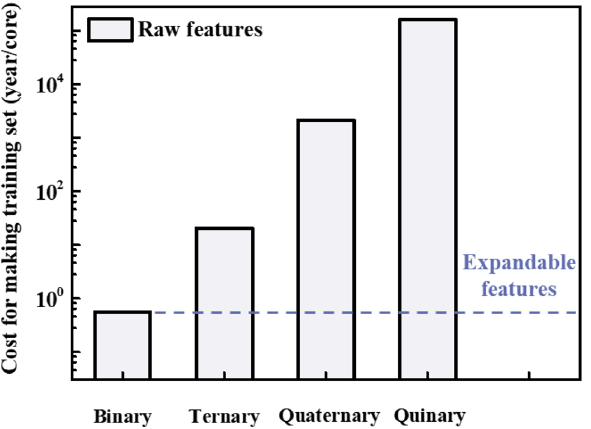
Figure 4. ( a ) S c of binary alloy as a function of c (Gray line). S alloy can have. Beige color and orange color denote the MEA (Medium entropy alloy) and HEA region, respectively. ( b ) Data distribution of calculated binary alloy and experimental data (binary alloy, ternary alloy, HEA) in and S c feature.